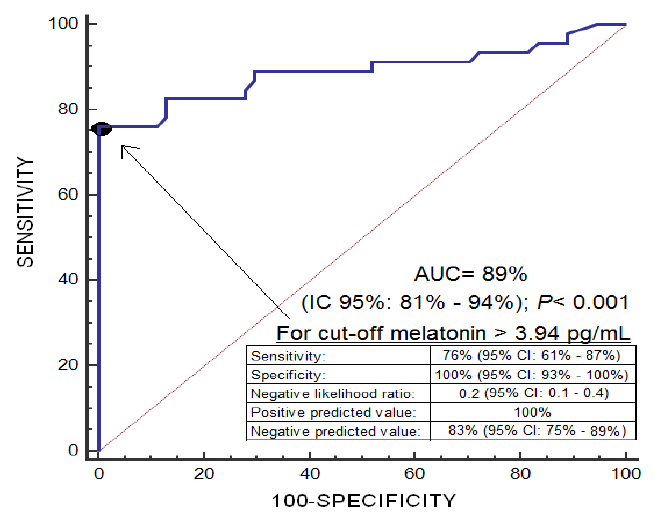
Figure 1. Receiver operation characteristic analysis using serum melatonin levels as a predictor of mortality at 30 days.